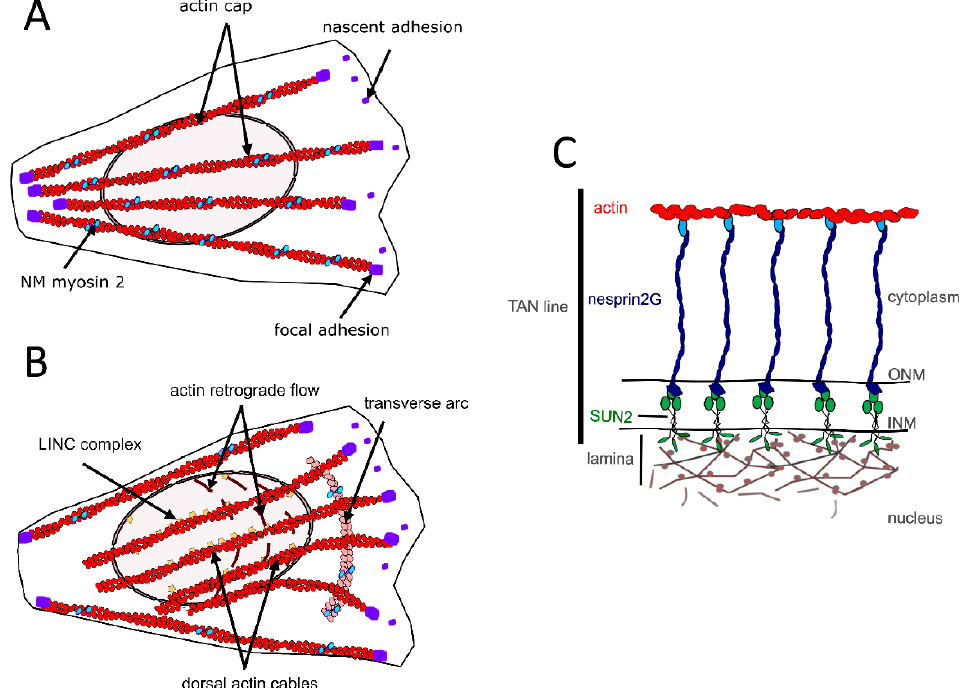
Figure 2. Components of the perinuclear actin network in muscle cell precursors (MCPs). ( A ) Actin cap formed by dorsal stress fibers. ( B ) transmembrane actin-associated nuclear (TAN) lines. ( C ) Illustration of the molecular composition of a TAN line. TAN